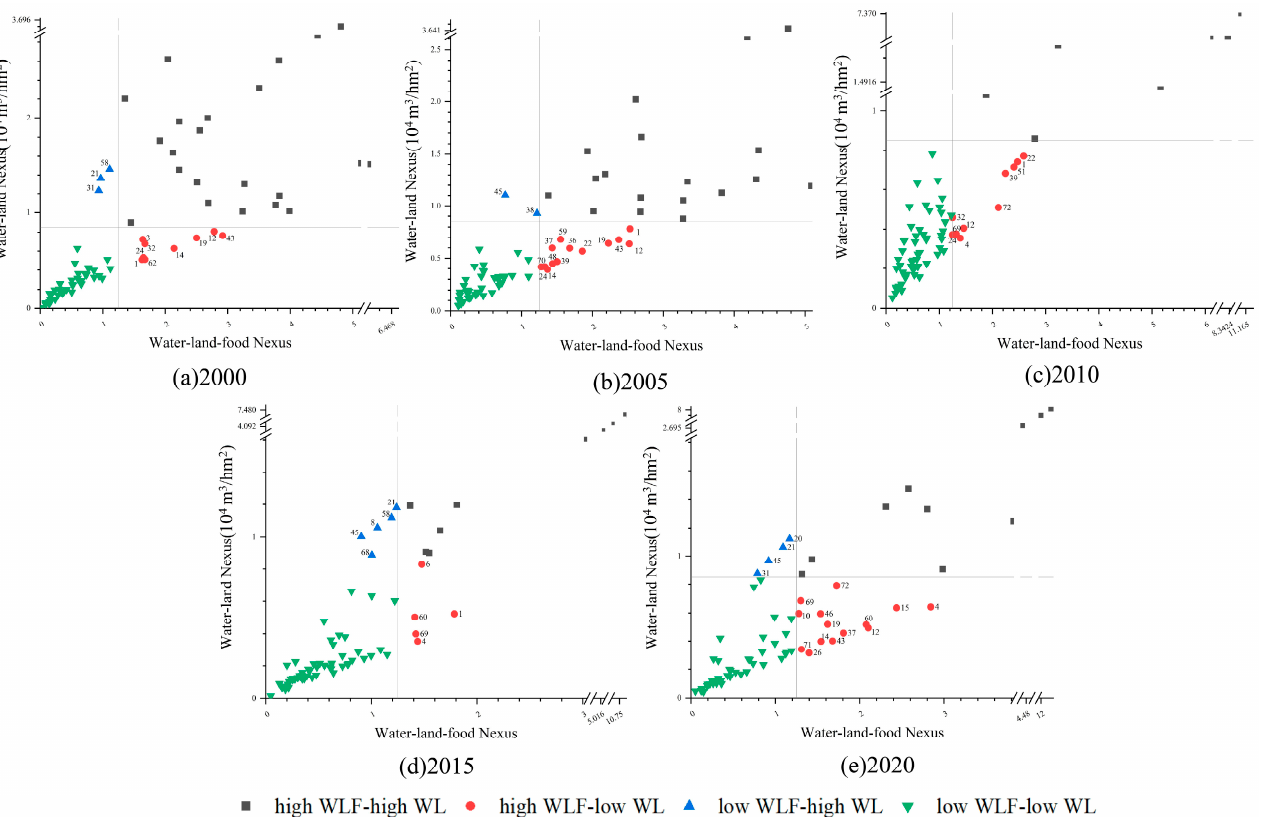
Figure 8. Water–land nexus and water–land–food nexus of 74 cities in the main grain-producing areas of North China. ( a ) 2000 ( b ) 2005 ( c ) 2010 ( d ) 2015 ( e ) 2020. All input cities and theircode numbers are shown in Appendix A.